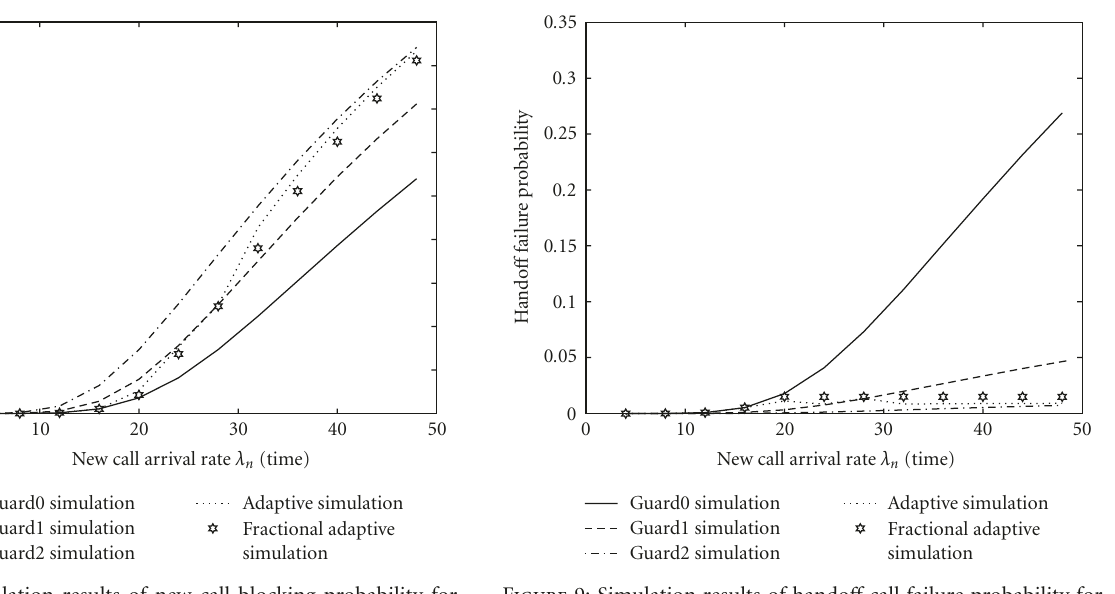
Figure 8: Simulation results of new call blocking probability for nineteen-cell wrap around structure.